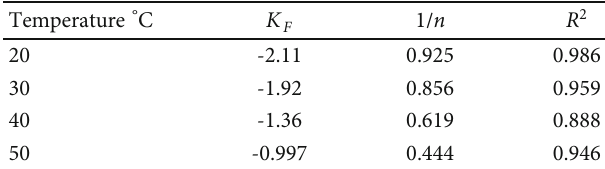
Figure 6: Freundlich adsorption isotherm of PDL extract for aluminium corrosion in (1 M HCl) at di ff erent temperatures. Table 4: Langmuir equilibrium constant, standard adsorption free energy and correlation coe ffi cient for Langmuir adsorption isotherm of the PDL extract inhibitor for aluminium corrosion at di ff erent temperatures.